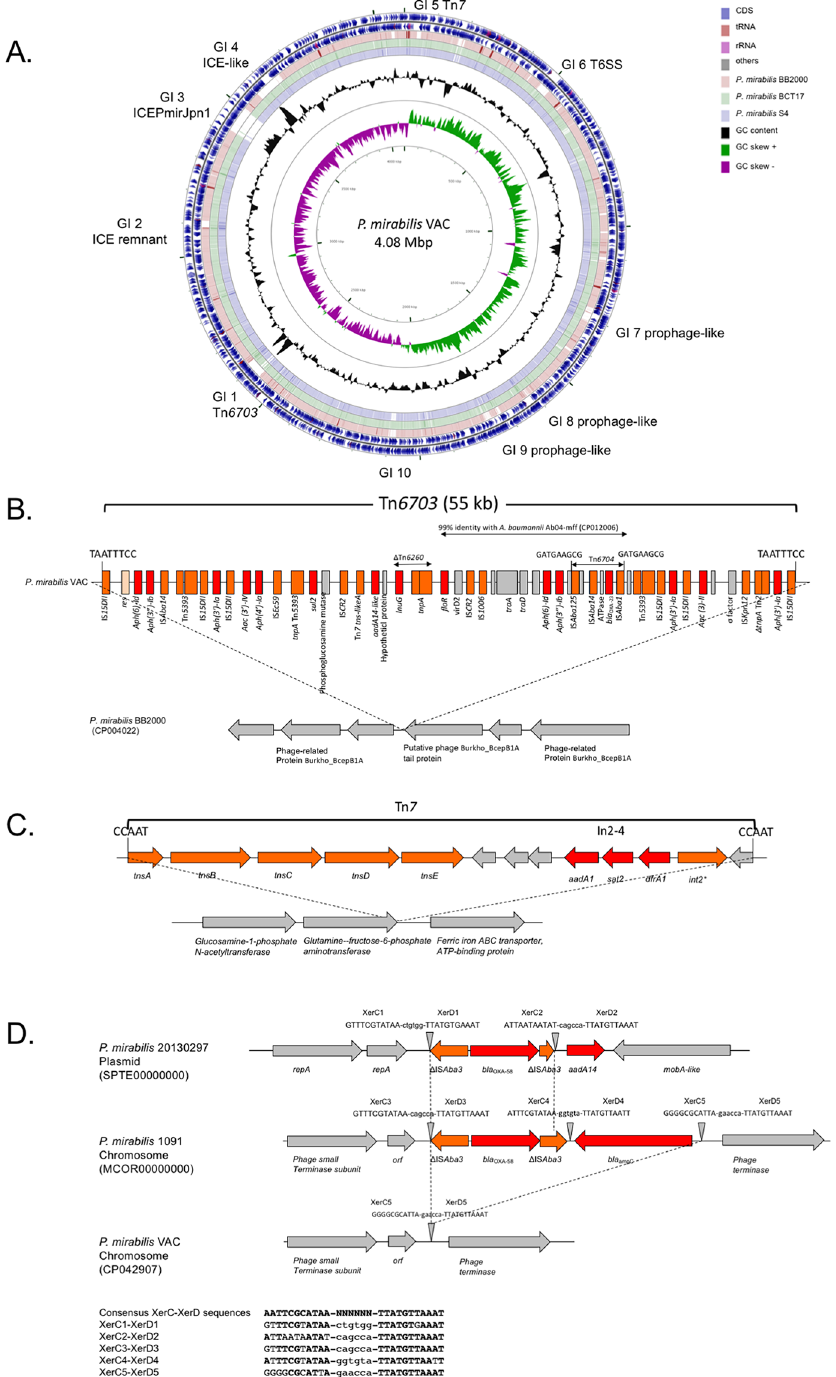
Figure 2. ( A ) Comparative genomic of P. mirabilis VAC. Genome analysis of P. mirabilis VAC and its comparison with P. mirabilis S4 (1996), P. mirabilis BCT17 (2017) and P. mirabilis BB2000 reference genome (CP004022). Circular representation was obtained using CGViewer. Inner circles represent CG content (black circle) and CG Skew (green & purple circle). GI = Genomic Island (B) Schematic representation of IS 15 ∆ II - based composite transposon (Tn 6703 ) and its insertion site. Red boxes represent resistance genes and orange boxes represent mobile elements. (C ) Schematic representation of Tn 7 . Genes are indicated by arrows. Red arrows represent resistance genes and orange arrows represented mobile elements. (D) Analysis of the genetic context of bla OXA-58 in P. mirabilis 1091 and 20130297 isolates. XerC-XerD binding sites are indicated by triangles. Dashed lines represent DNA